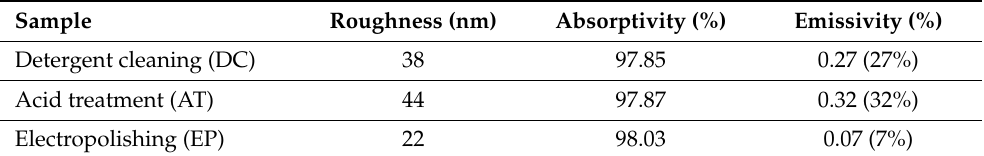
Table 6. Coatings’ roughness, absorptivity, and emissivity according to the treatments that were performed and 1 min of deposition time (DC-Detergent cleaning, AT-Acid treatment, EP- Electropolishing).